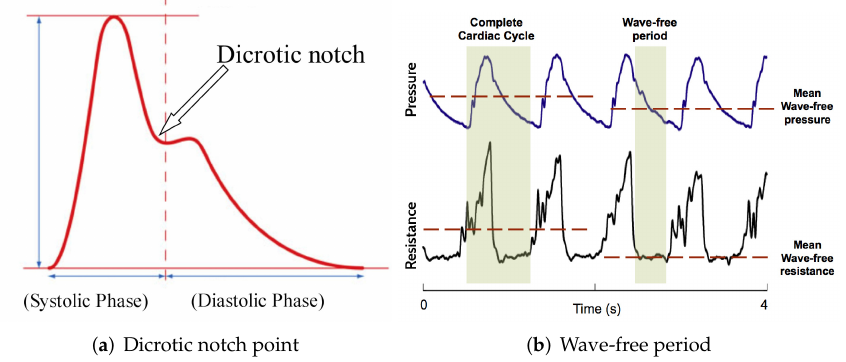
Figure 3. Dicrotic notch point and wave-free period characteristics in the blood pressure